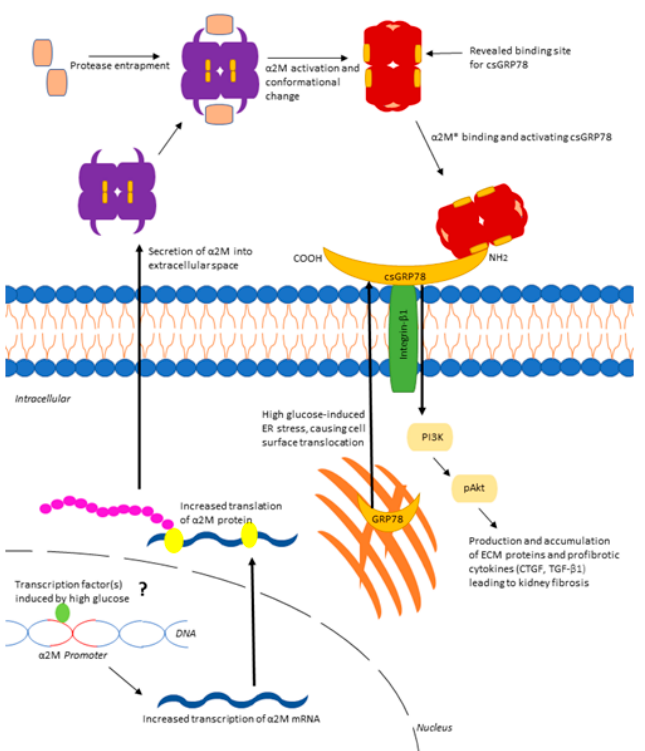
Figure 8. Proposed pathway for HG-induced α 2M*/csGRP78 mediated profibrotic signaling in MCs. HG leads to increased synthesis (likely by HG-responsive transcription factors, but this has yet to be elucidated as indicated by “?” in the figure) and activation of α 2M as well as translocation to the cell surface of its receptor GRP78. Interaction between α 2M*/csGRP78 leads to activation of Akt and downstream synthesis of profibrotic cytokines and extracellular matrix proteins. Supplementary Materials: The following are available online at www.mdpi.com/link, Figure S1: Separate analysis of α 2M in tubules and glomeruli for ( A ) in situ hybridization (ISH) in 40-week- Akita mice. Figure S2: Separate analysis of α 2M* in tubules and glomeruli in ( A ) Akita mice at 18, 30, and 40 weeks of age; ( B ) 16-week-old uninephrectomized streptozotocin-induced type 1 diabetic CD1 mice; and ( C ) human biopsy samples from control and DKD patients. Figure S3: Assessment of a non-diabetic chronic kidney disease mouse model shows significantly increased α 2M* expres- sion in 5/6 nephrectomized mice compared to sham-operated control mice ( A ). Separate quantifica- tion of tubules and glomeruli shows increased expression in both compartments ( B ). Author Contributions: J.T., R.L. and B.G. performed experiments; J.C.K. conceived the experi- mental design; J.T. analyzed the data; J.T. and J.C.K. wrote the manuscript; Y.P. and T.E.A. created the F α 2M antibody; Y.P. and J.J.S. conducted the α 2M* ELISA; M.D.I. analyzed patient data; S.T.